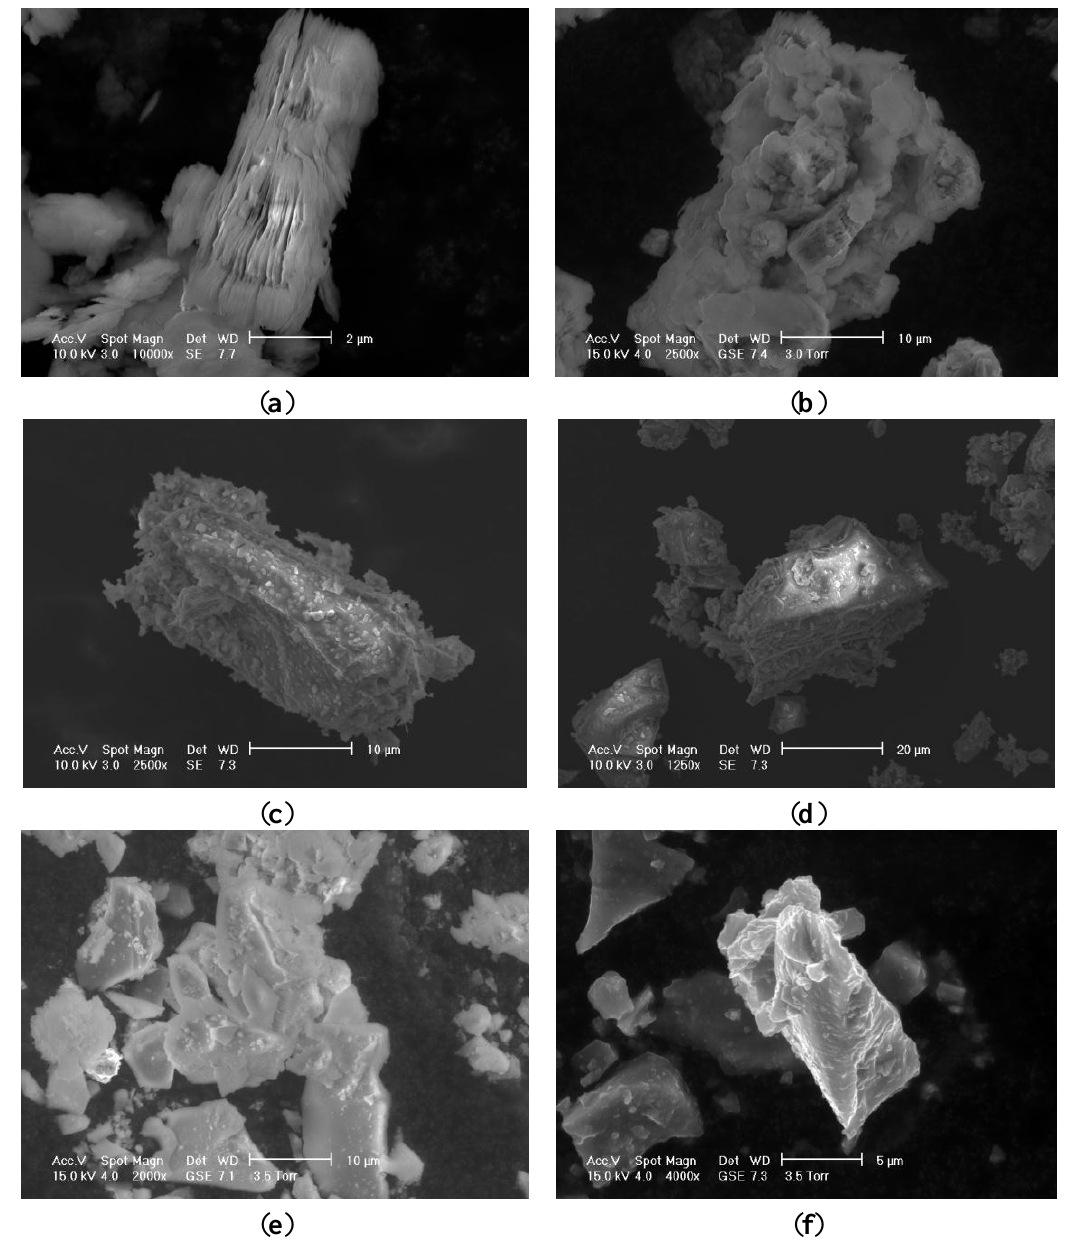
Figure 3. Morphologies in ESEM of ( a ) Kaolin powder; ( b ) Paraffin-Kaolin composite PCM; ( c , d ) GGBS particles; ( e , f ) Paraffin-GGBS composite